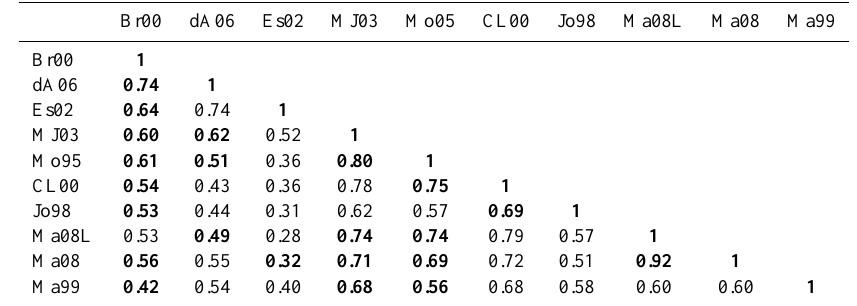
Table 5. Mutual correlation ρ between millennial (1000 to 1850) reconstructions, using variations ≥ 5y. Bold numbers indicate significance (99%) for the detrended